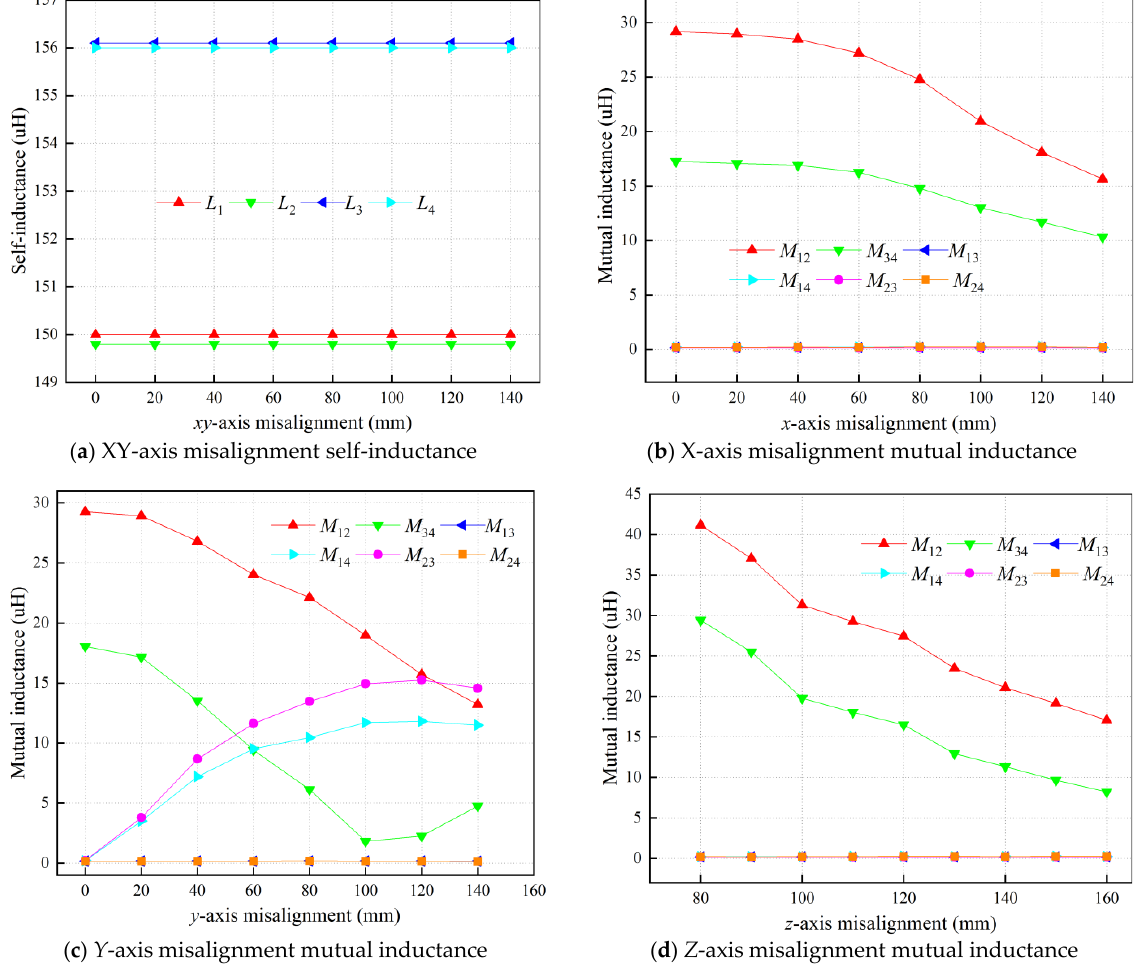
Figure 5. The measured self and mutual inductances of the DDQ pads.